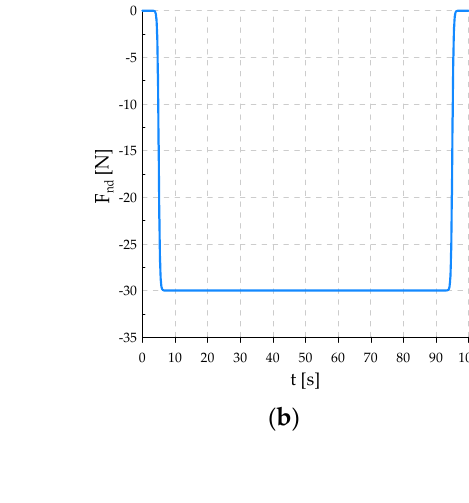
Table 3. Control system parameters.